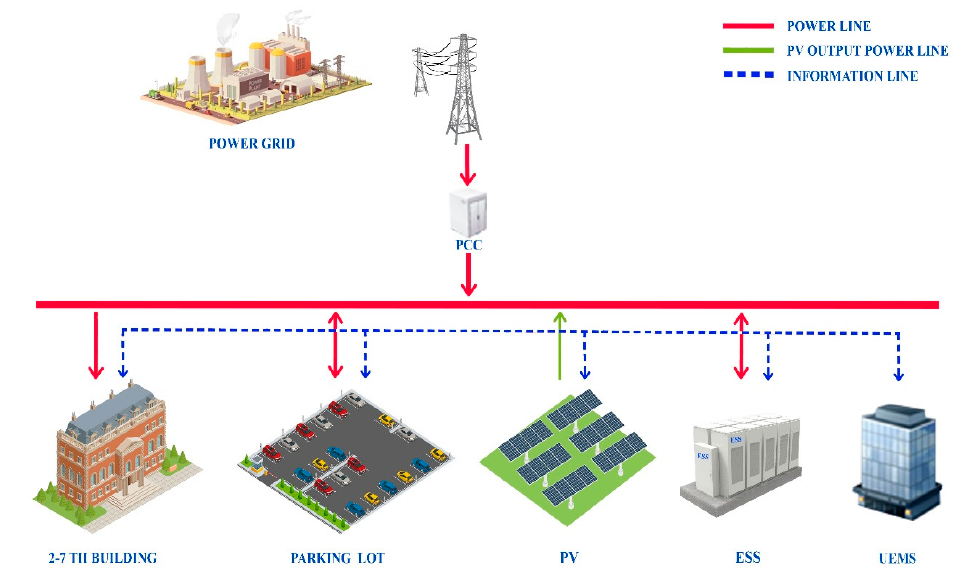
Figure 1. System model. PCC: point of common coupling; PV: photovoltaic; ESS: energy storage system; UEMS: university energy management system.